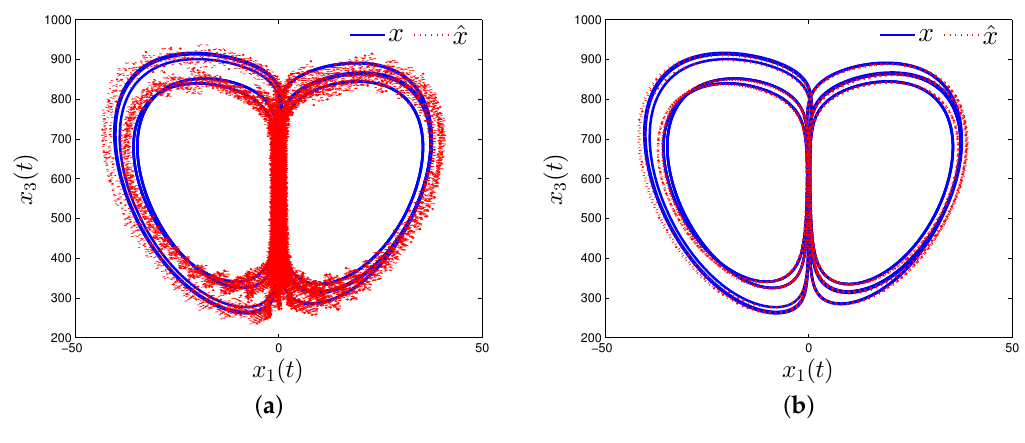
Figure 6. Phase portrait ( x 1 , x 3 ) : ( a ) SMO. ( b )